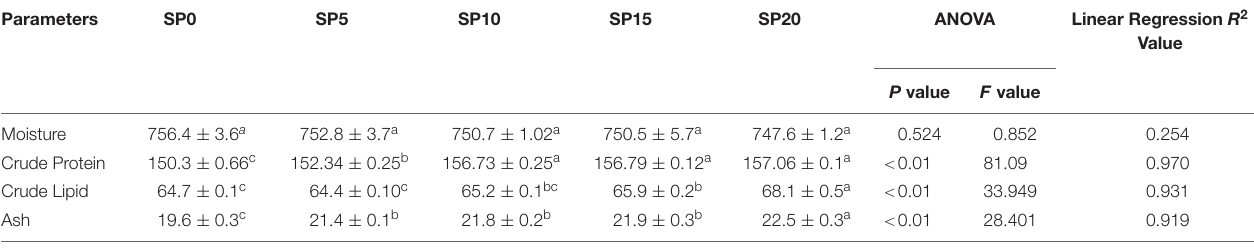
TABLE 3 | Proximate compositions (g/kg, wet weight) of five different diets-fed Cyprinus carpio . Parameters SP0 SP5 SP10 SP15 SP20 ANOVA Linear Regression R 2